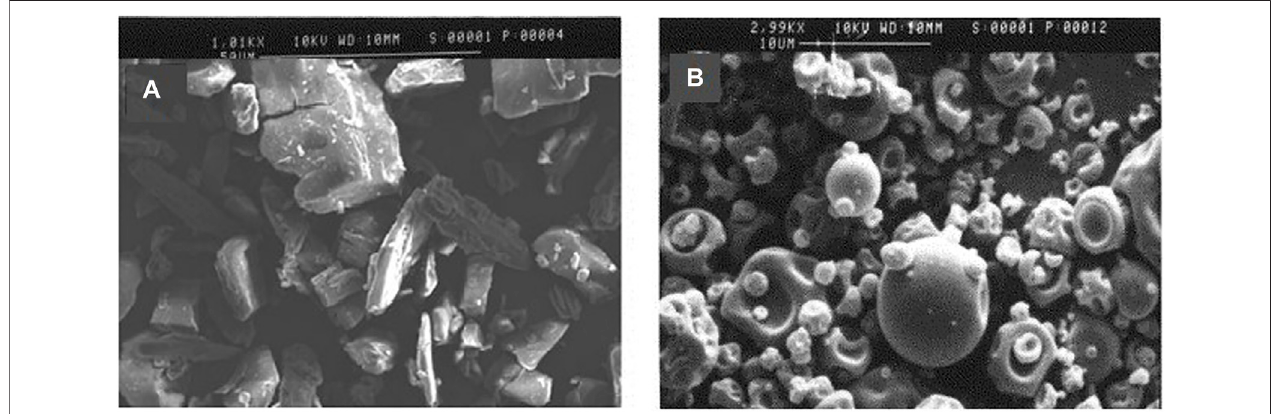
FIGURE 2 | SEM images of (A) CMN and (B) CSDs prepared with PVP K 30 (1:3